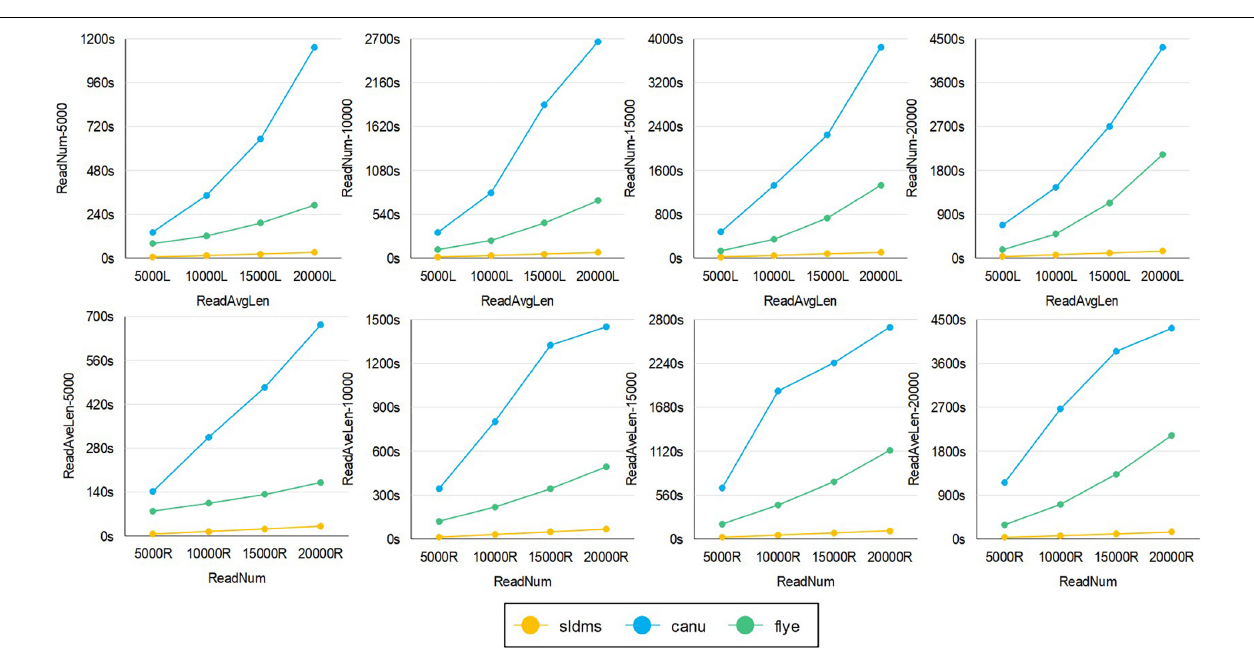
FIGURE 9 | The time required for different software to run simulation datasets with errors to find overlapping